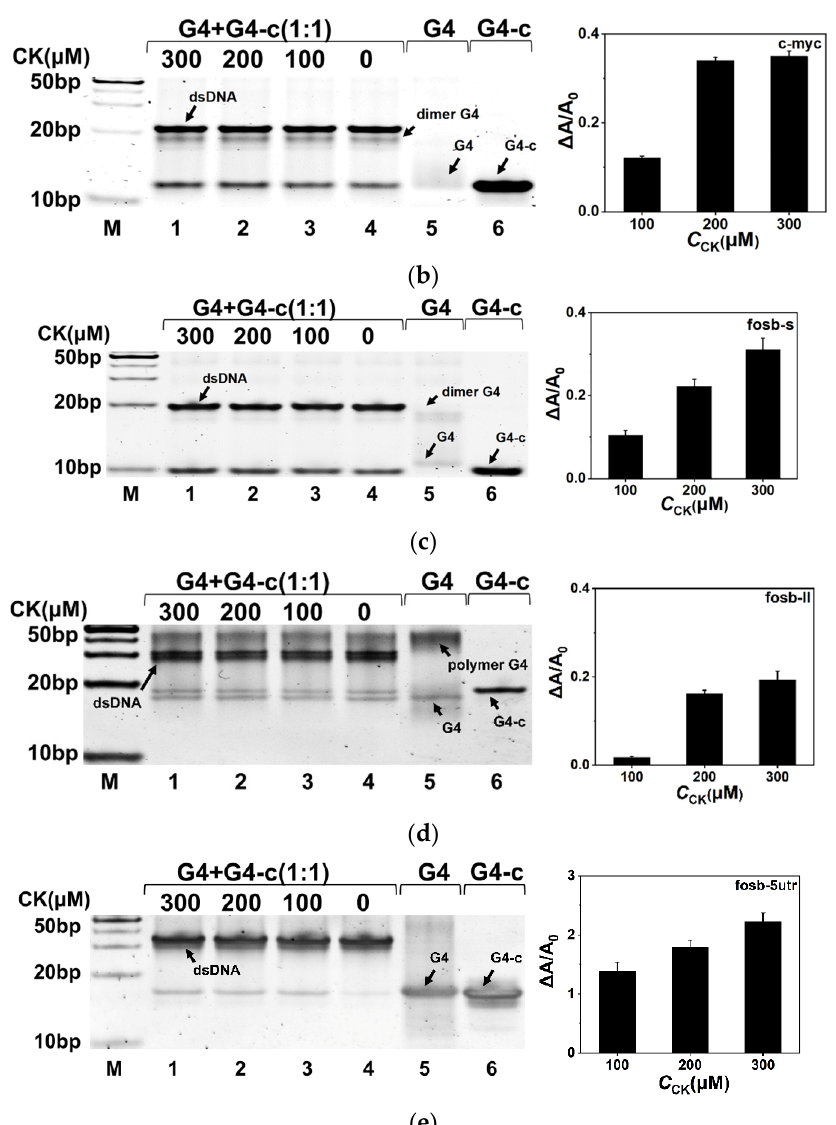
Figure 4. Native gel electrophoresis of ( a ) telo, ( b ) c-myc, ( c ) fosb-s, ( d ) fosb-ll, and ( e ) fosb-5utr. Lane M showed 10 bp marker. Lanes 1–4 were double strands of each G4 in the presence of 300, 200, 100, and 0 μ M CK. Lane 5 was single strand of G4, and lane 6 was its complementary strand. The histograms on the right show the area changes of G4s in the presence of